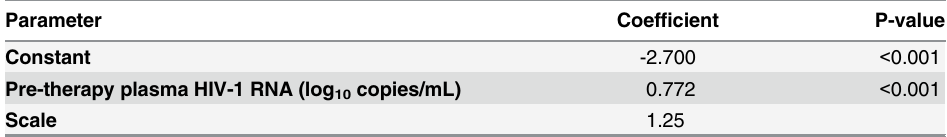
Table 2. Log-normal model parameter estimates for on-therapy plasma HIV-1 RNA levels as a function of baseline pre-therapy plasma HIV-1 RNA